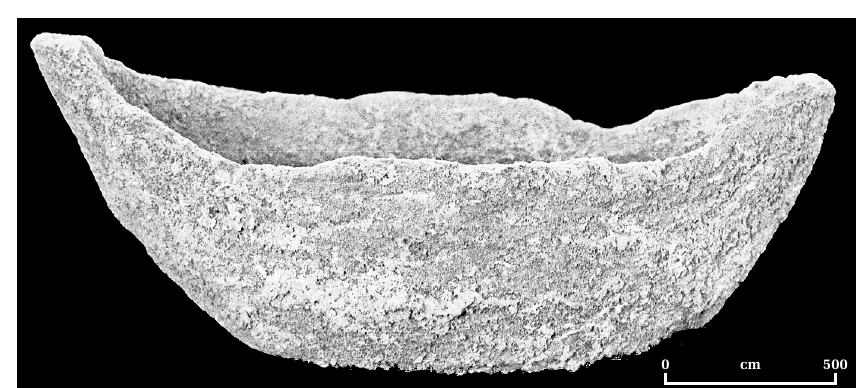
diameter, from the H3 site, with a design resembling a boat with two masts.